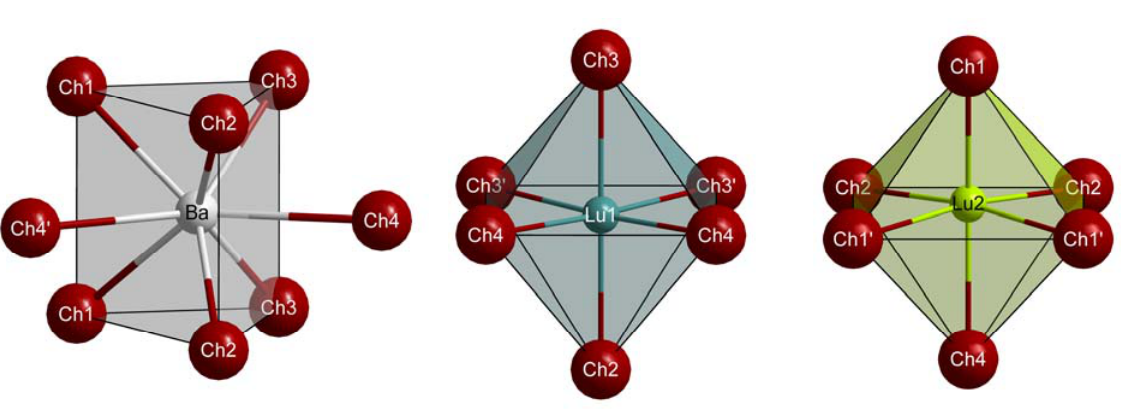
Ch series ( Ch = S, Se and 2 4